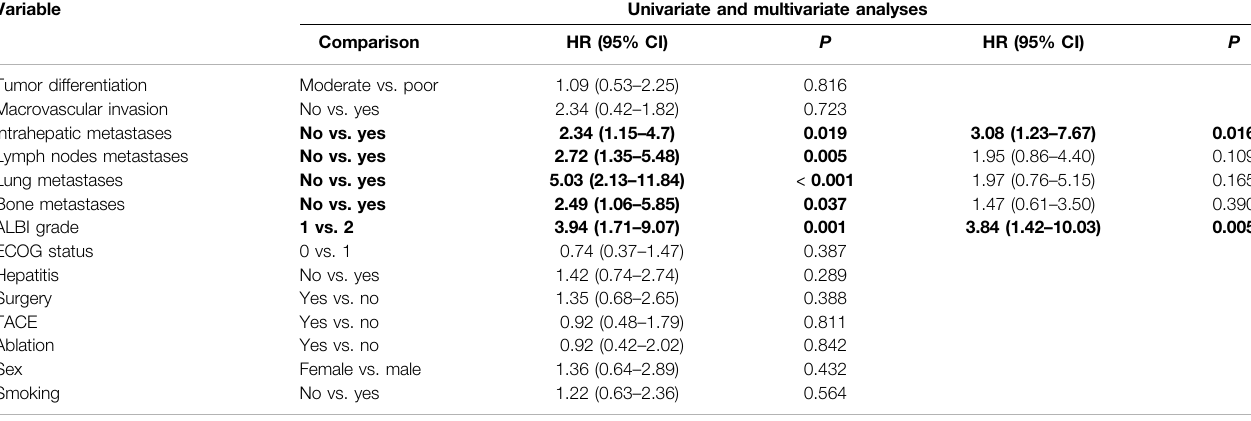
TABLE 4 | Univariate and multivariate analyses of prognostic factors on progression-free survival (PFS) in 40 patients with advanced ICC after chemotherapy failure. Variable